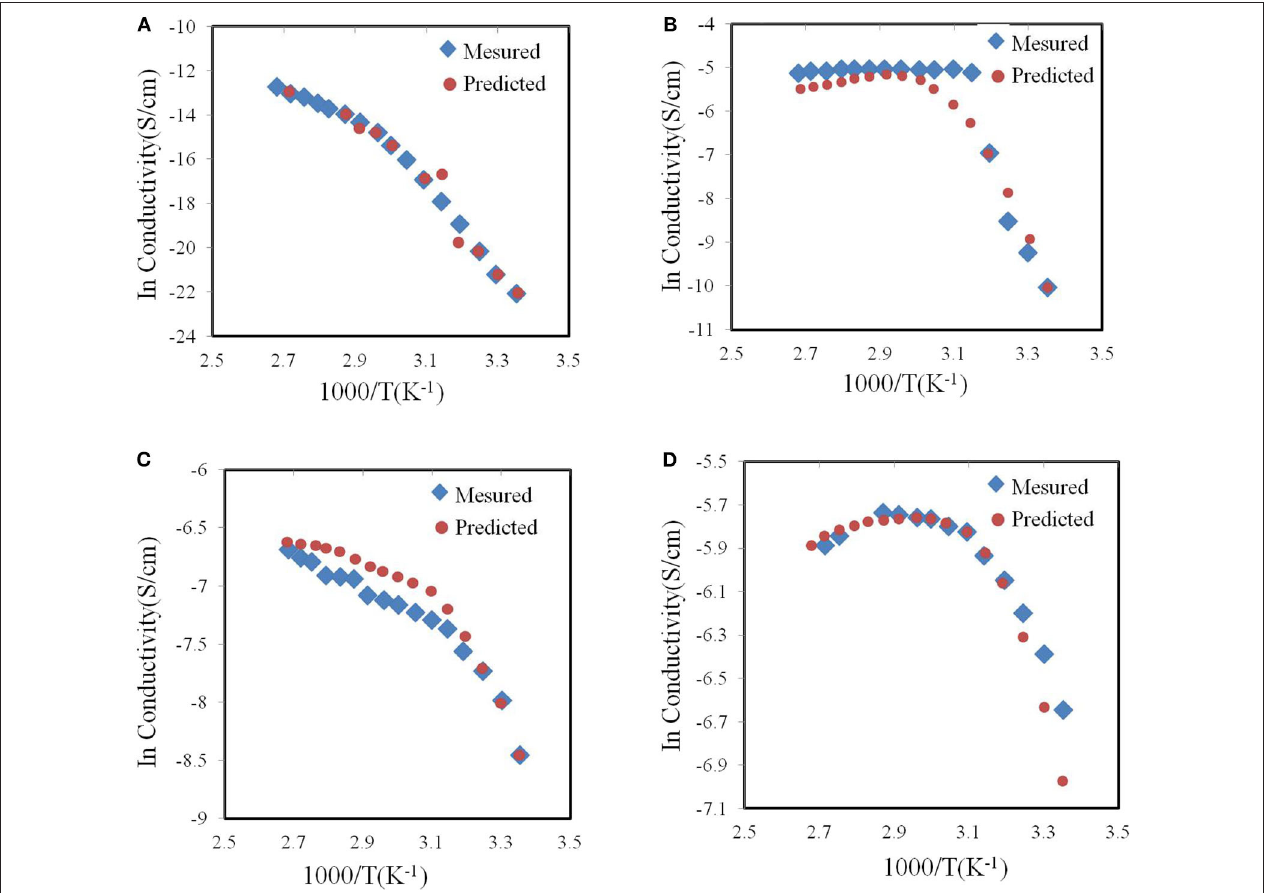
FIGURE 8 | Neural network predicted and experimentally measured curves of (A) pure PEO conductivity (B) pure PEO–Salt conductivity (C) PEO–Salt–EC conductivity and (D) PEO–Salt–EC–CNT conductivity according to